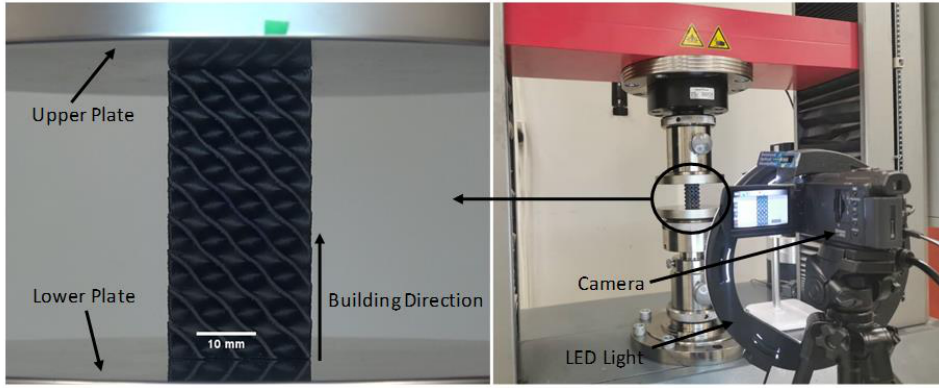
Figure 4. Compression Testing Setup.